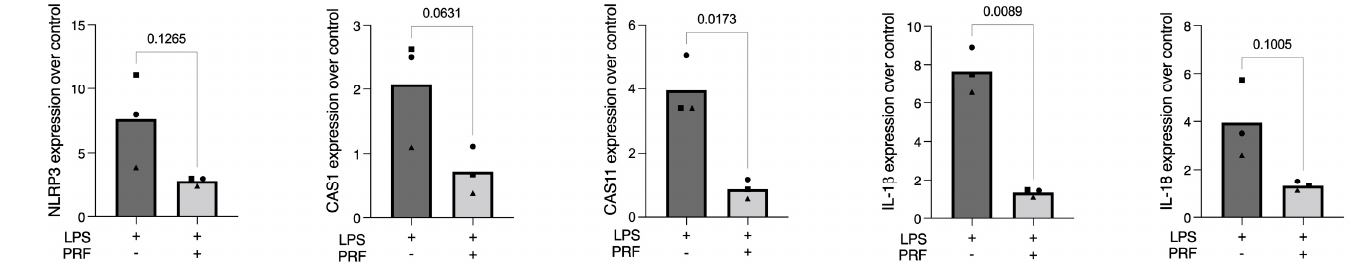
Figure 1. PRF reduces the expression of pyroptosis-related genes in LPS-induced RAW 264.7 macrophages. A significant reduction in CAS11 and IL-1 β in LPS-induced RAW 264.7 macrophages was reported. Gene expression is compared to the untreated control, and each data point represents an independent experiment. n = 3. To compare groups, paired t -test was applied.